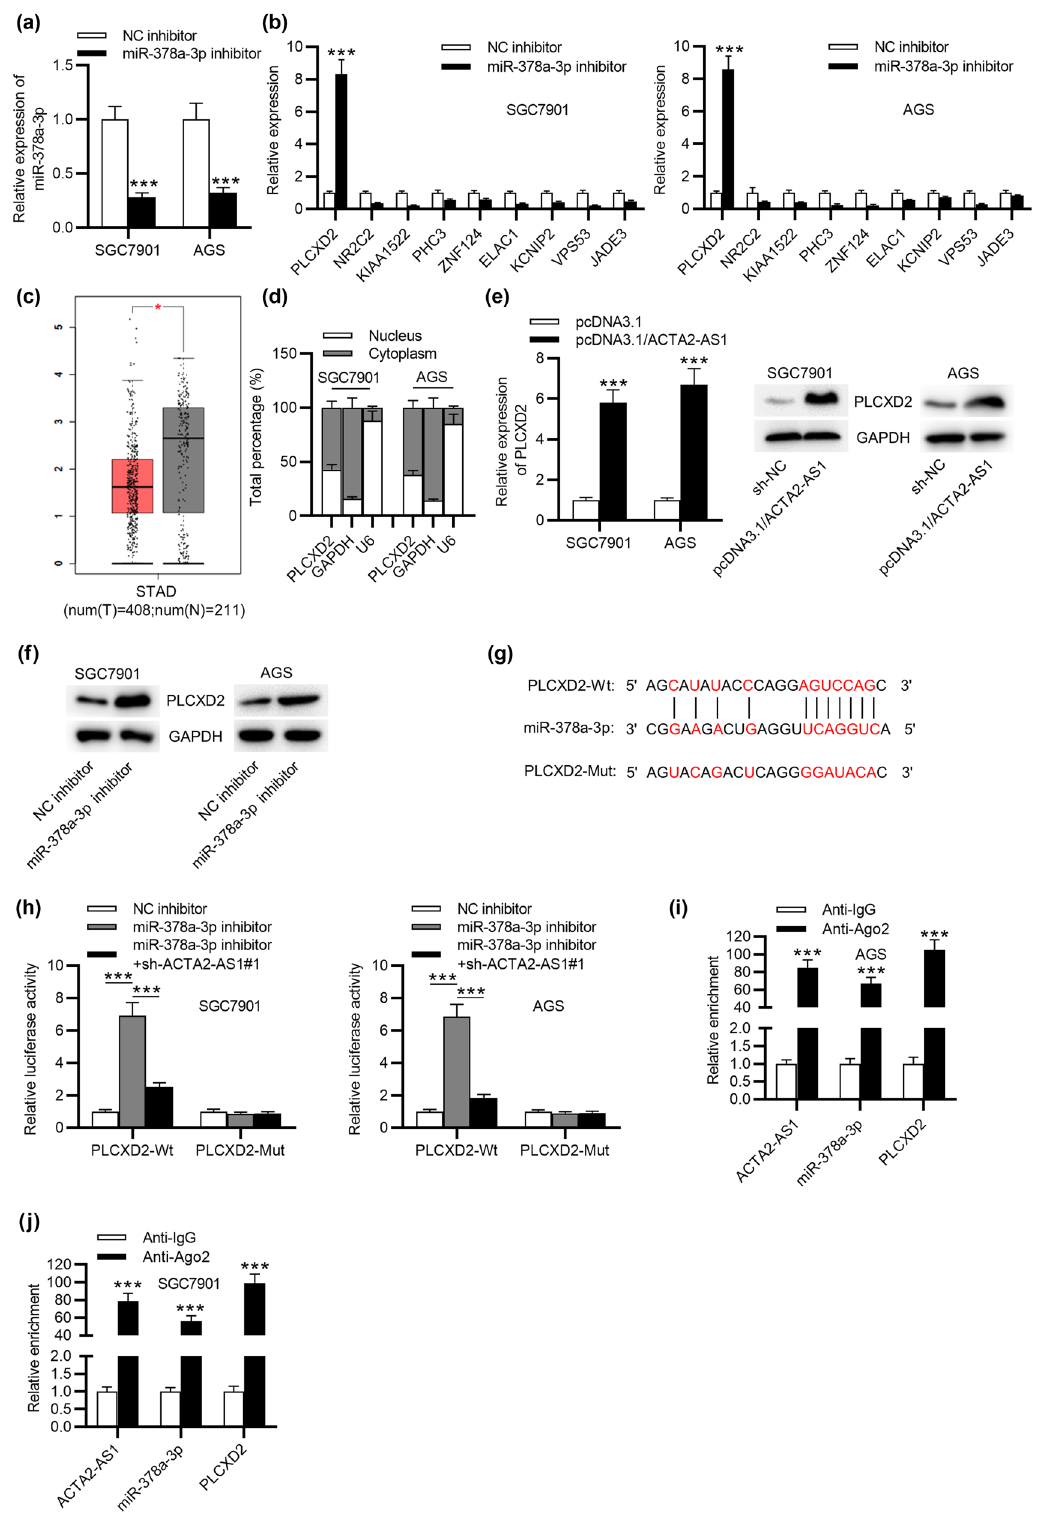
Figure 4: ACTA2 - AS1 upregulates PLCXD2 expression by binding with miR - 378a - 3p. ( a ) Knockdown e ffi ciency of miR - 378a - 3p inhibitor in SGC7901 and AGS cells was examined using RT - qPCR. ( b ) Nine mRNAs containing binding site with miR - 378a - 3p were predicted with miRDB. RT - qPCR was employed to detect the e ff ect of miR - 378a - 3p inhibition on the expression of these candidate mRNAs. ( c ) The expression of PLCXD2 in STAD tissues ( n = 408 ) and normal tissues ( n = 211 ) was analyzed by GEPIA. ( d ) Subcellular fractionation assays were performed to detect the primary localization of PLCXD2. ( e ) The impacts of ACTA2 - AS1 overexpression on mRNA and protein levels of PLCXD2 were measured by RT - qPCR and Western blot. ( f ) Western blot was conducted to detect protein level of PLCXD2 in GC cells transfected with miR - 378a - 3p inhibitor or NC inhibitor. ( g ) The binding site between miR - 378a - 3p and PLCXD2 was predicted from miRDB website. ( h – j ) Luciferase reporter assays and RIP assays were applied to explore the relationship among ACTA2 - AS1, miR - 378a - 3p, and PLCXD2. *** p <